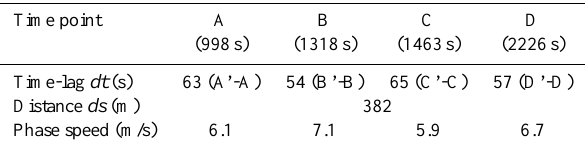
Table 2. Tsunami propagation speeds computed by computing the travel time over a distance between two different locations selected from the first and third video view sectors. A and A’, B and B’, C and C’, and D and D’ are time point pairs representing the travel times of individual tsunami waves (Fig.